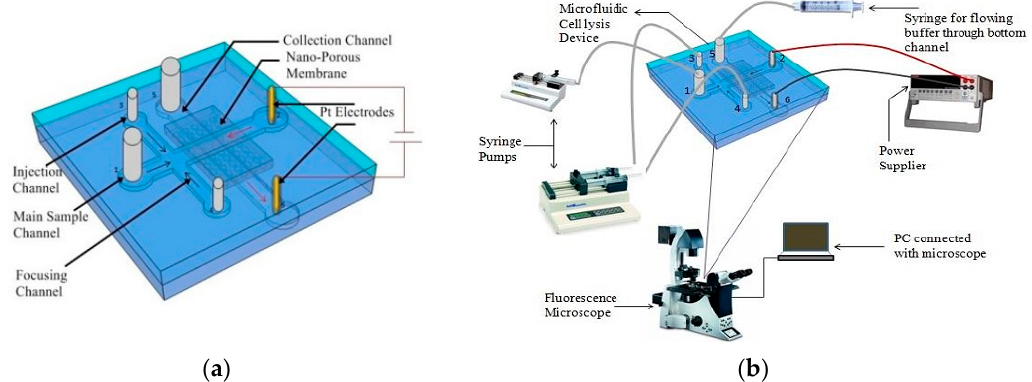
Figure 17. Electrical cell lysis microfluidic device: ( a ) schematic of cell lysis device; and ( b ) experimental setup. Reproduced with permission from [96]. Table 4. Different electrical lysis devices used for cell